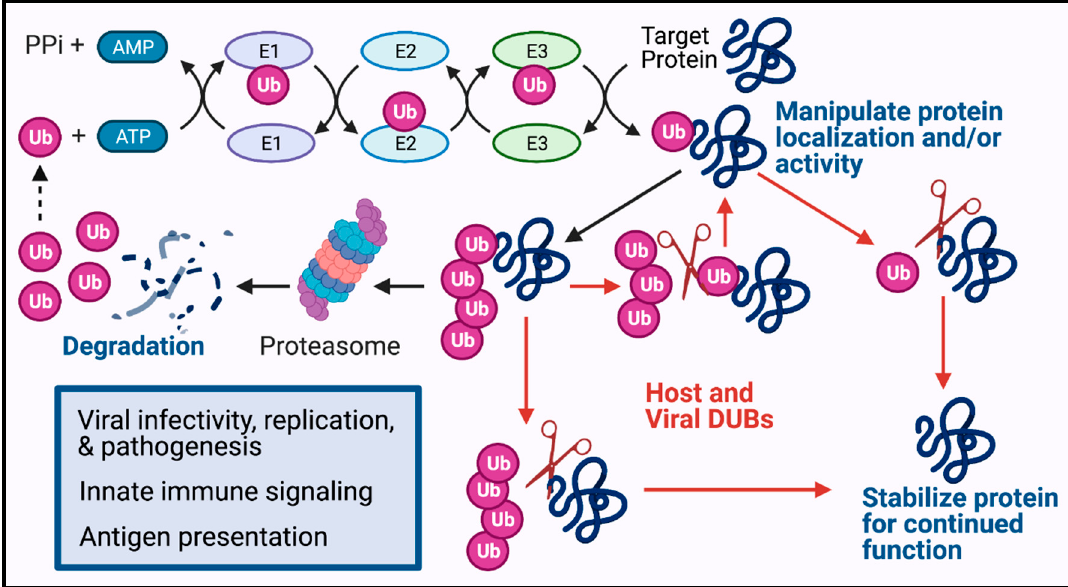
Figure 1. Deubiquitination counteracts ubiquitination within the UPS by cleaving the peptide or isopeptide bond between Ub and its substrate proteins as well as between Ub molecules in a chain to reverse the fate of the ubiquitinated proteins. Viruses utilize DUBs to evade host immune response and expedite their survival. DUB pathways are illustrated by red arrows. Dotted lines denote Ub recycling. Blue text indicates ‘protein fate’ which coordinates outcomes that are regulated by the Ub system during host–viral interactions (blue box). Image made with BioRender.com.